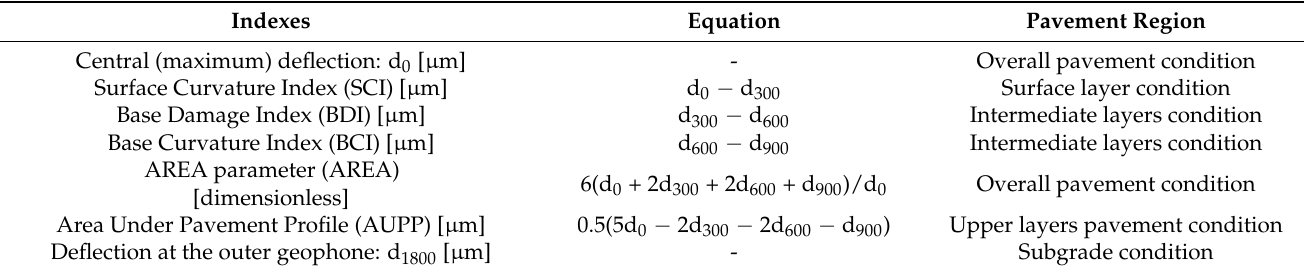
Table 1. Deflection-Based Parameters (DBPs).